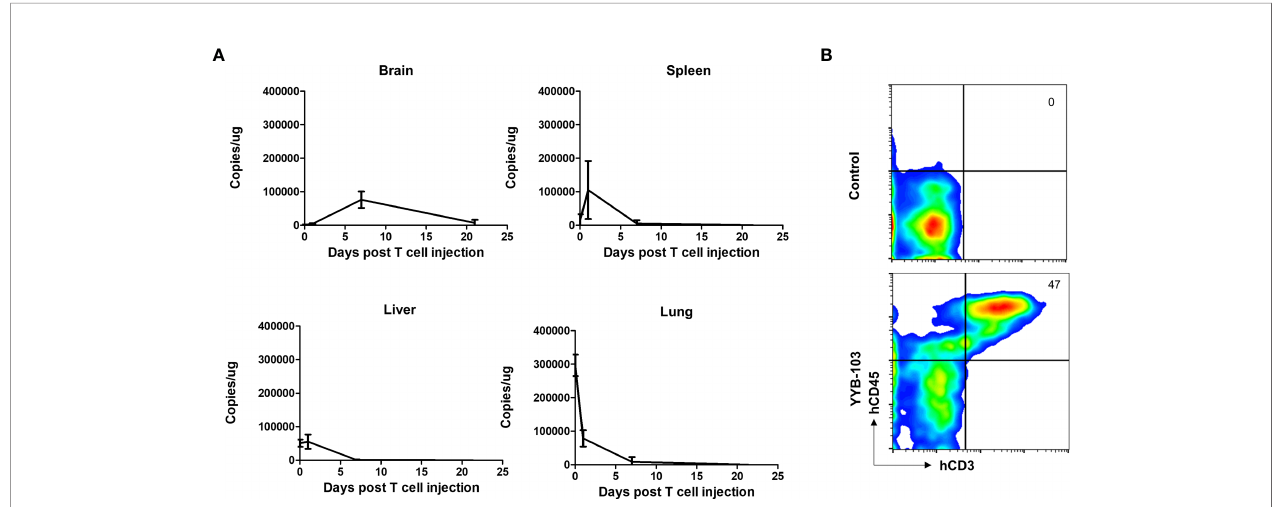
FIGURE 4 | Biodistribution of i.v. injected YYB-103 CAR T cells in a mouse tumor model. NOD/SCID mice were orthotopically injected with U87-luc and further administered YYB-103 CAR T cells 16 days after tumor implantation. Brain, spleen, liver, and lung tissues were collected at 3 h ( n = 5), 1 day ( n = 5), 7 days ( n = 4), or 21 days ( n = 2) after the CAR T i.v. injection. (A) Quantity of YYB-103 CAR T cells measured by qPCR of genomic DNA for the YYB-103 transgene in each organ on the indicated days. (B) Representative fl ow cytometry plots of human T cells in fi ltrated into mouse brain. Seven days after administration of YYB-103, lymphocytes were isolated from mouse brains using Percoll, and fl uorescence-activated cell sorting analysis was performed using human CD3-APC and CD45 PE- Cy7. i.v., intravenous; CAR, chimeric antigen